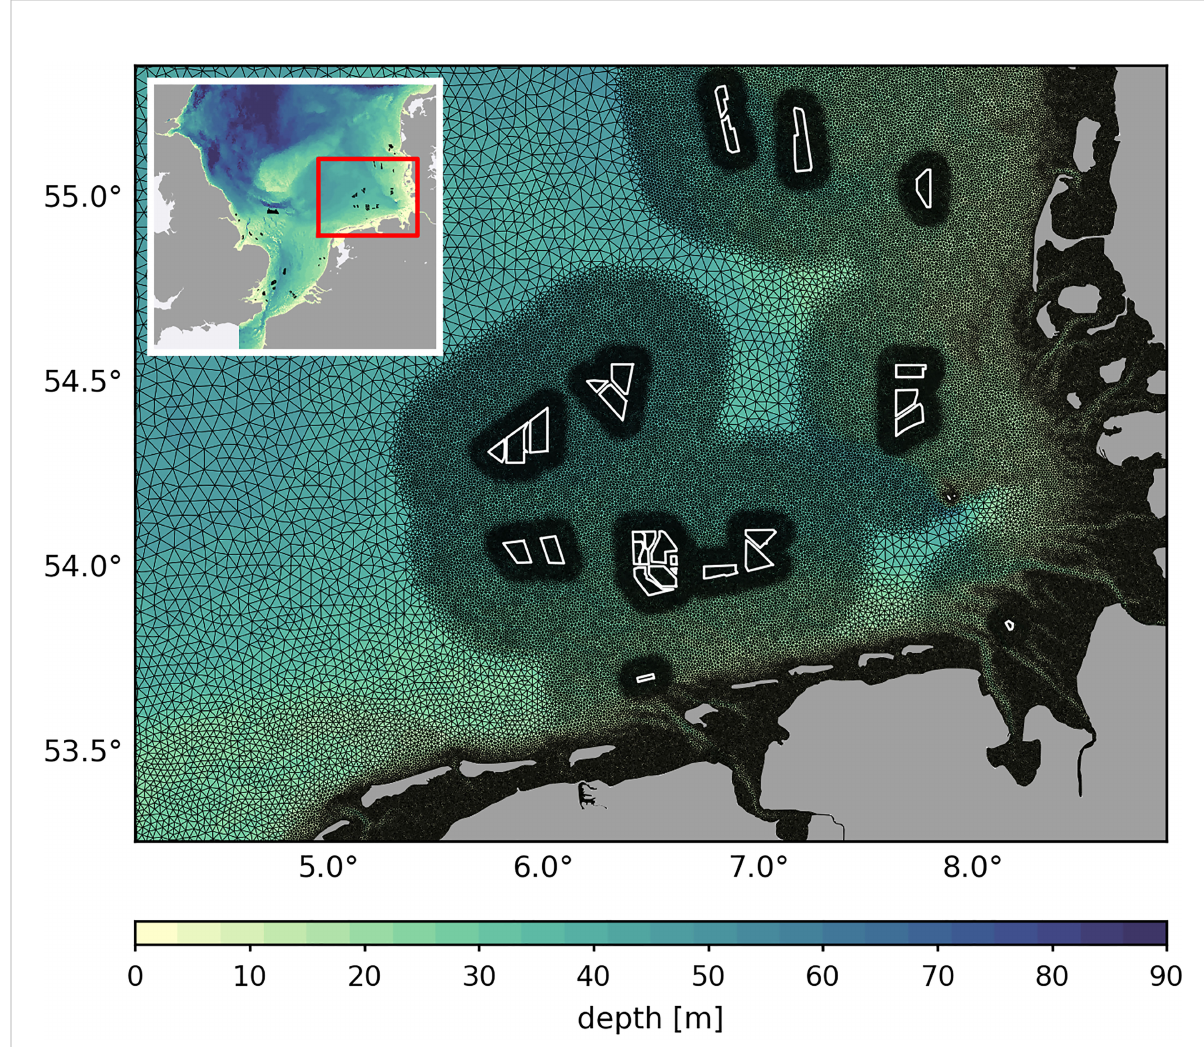
FIGURE 1 Horizontal grid resolution at offshore wind farms (white polygons) and near the coast. The entire model domain including all offshore wind farms used in this study (black polygons; data obtained from https://www.4coffshore.com/windfarms/) is shown in the top left